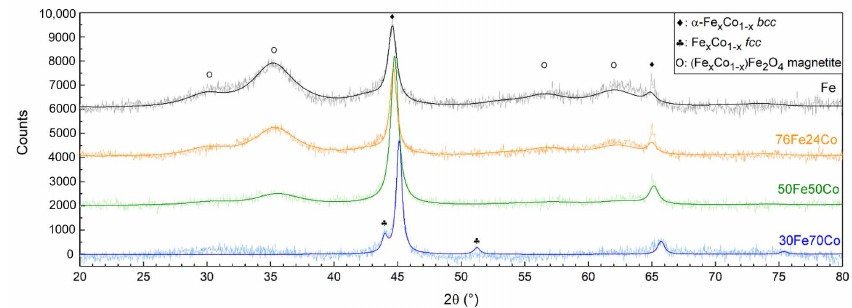
Figure 3. XRD patterns of the three Fe-Co nanoalloys compared to elemental Fe NPs. The peaks of the bcc Fe-Co alloy shift toward higher angles with increasing Co